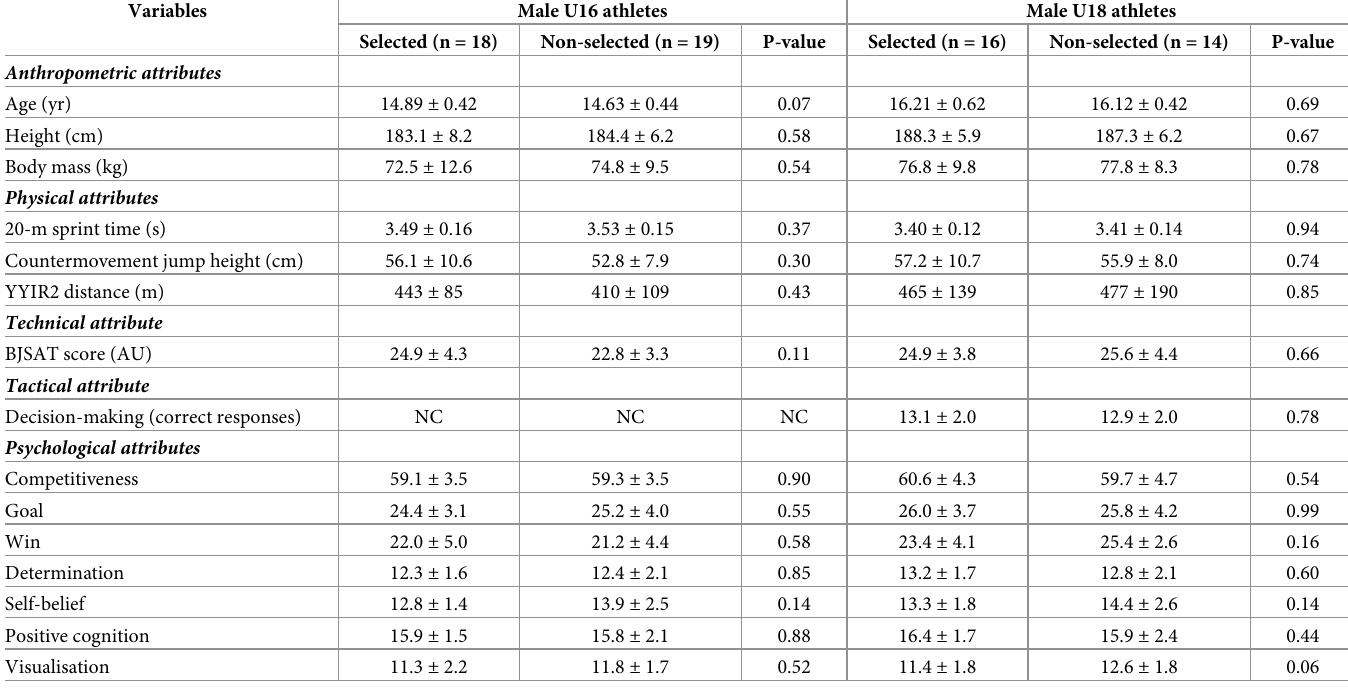
Table 1. Mean ± standard deviation anthropometric, physical, technical, tactical, and psychological attributes with statistical comparisons between selected and non-selected male adolescent basketball athletes according to age group.